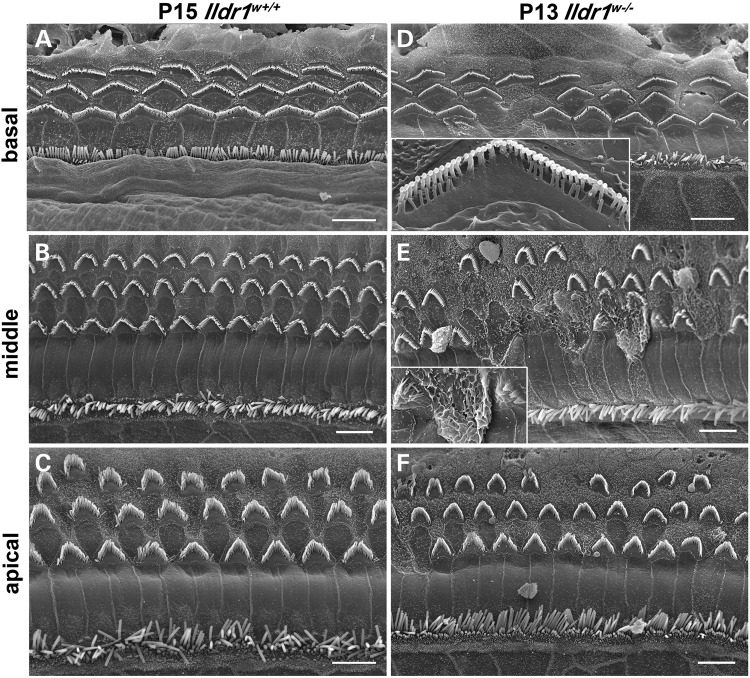
SEM images show OHC degeneration in the organ of Corti from P13 Ildr1w−/− mice in comparison to P15 Ildr1w+/+ controls. (A, D) basal turn, (B, E) middle turn and (C, F) apical turn. Note degeneration and loss of OHCs in all three turns of Ildr1w−/− mice. Inset in (D) shows a close-up view of a degenerating OHC from another image of the basal turn. Note the loss of shorter-row stereocilia. Inset in (E) shows close-up of degenerating OHC apical membrane fusion. IHC degeneration is not evident at P13. Scale bars: 5 mm.